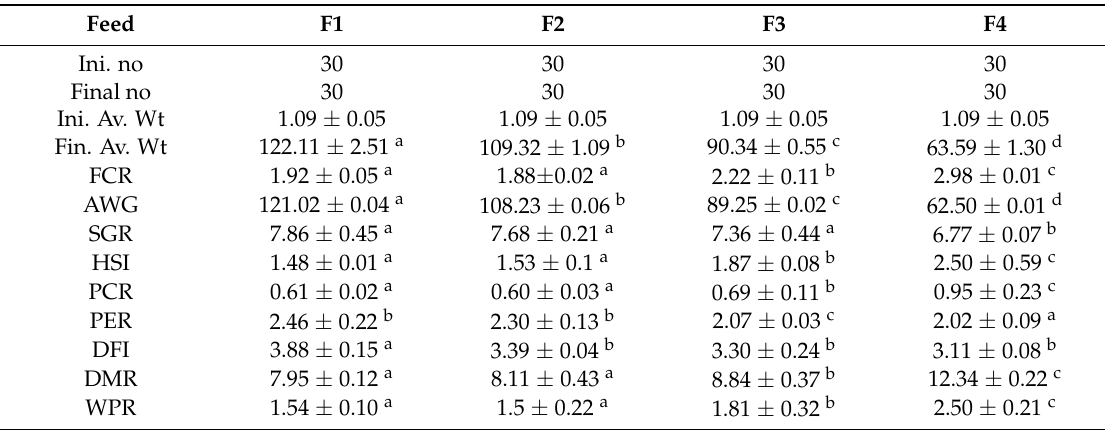
Ini. no = initial number of fish, Final no = final number of fish, Ini. Av. Wt = initial average weight, Fin. Av. Wt = final average weight, FCR = food conversion ratio, AWG = average weight gain, SGR = specific growth